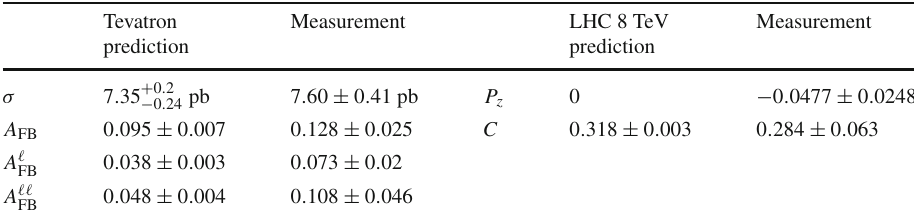
Table 1 Summary of SM predictions and experimental measurements used to constrain the parameter space of the light colour